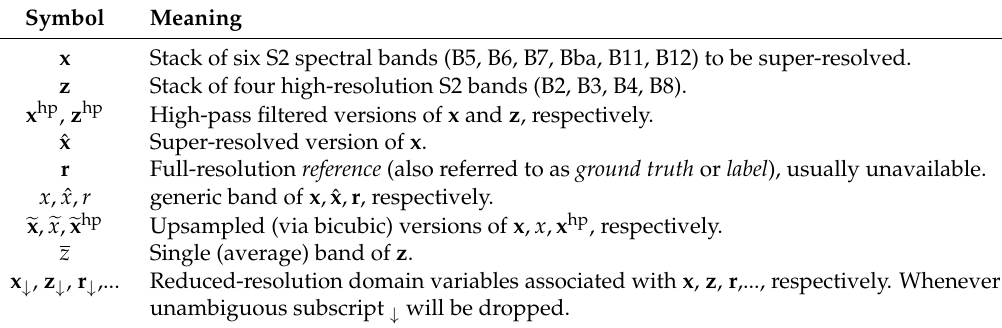
Table 2. Notations and